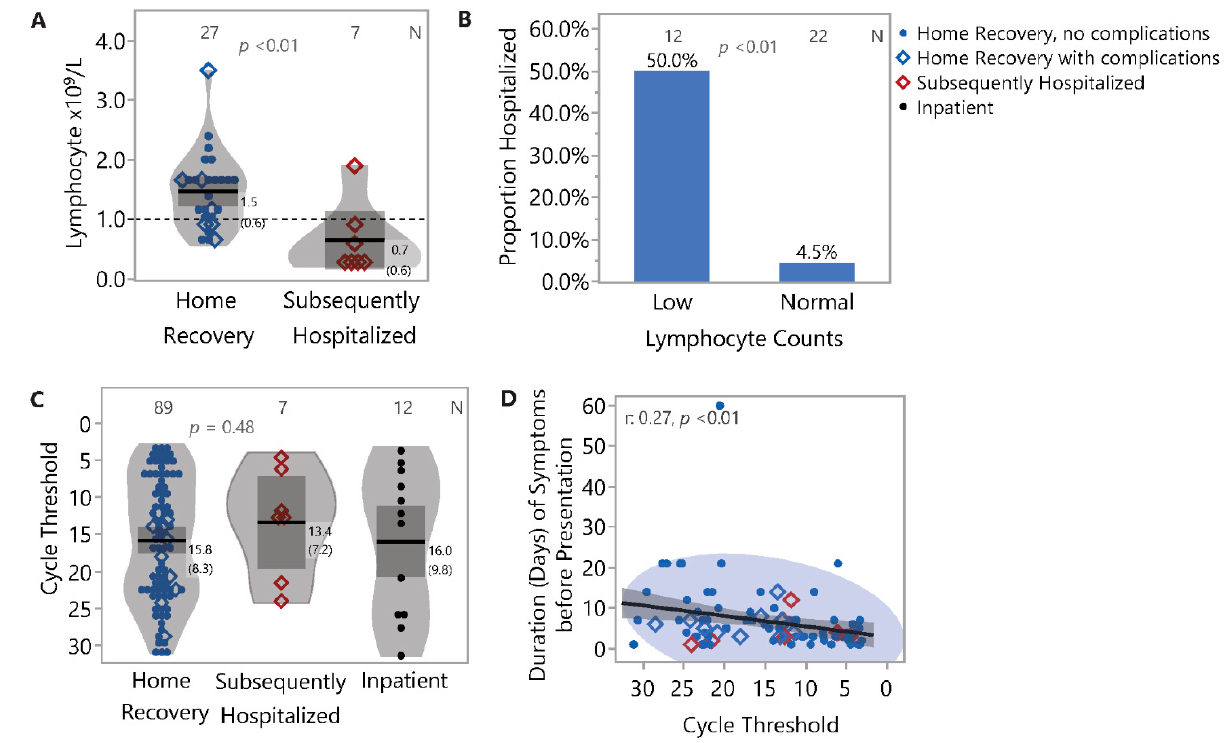
Figure 2. Association of lymphocyte counts and virus cycle threshold with clinical outcome. ( A ) Lymphocyte counts were lower in the Subsequently Hospitalized group compared to the Home Recovery group. Further, within the Home Recovery group, 50% (3/6) of those with lymphopenia had complications compared to 19% (4/21) among those with normal counts. ( B ) Low lymphocyte counts (<1.0 × 10 9 cells/L) were associated with increased risk for subsequent hospitalization. Fifty percent (6/12) of participants with low lymphocyte counts were subsequently hospitalized compared to only 4.5% (1/22) of participants with normal counts. ( C ) Cycle threshold data, a surrogate for viral load, was not significantly associated with outcomes. Lower cycle threshold values indicate higher levels of viral nucleic acid. ( D ) Duration of illness at presentation was inversely associated with the level of virus.